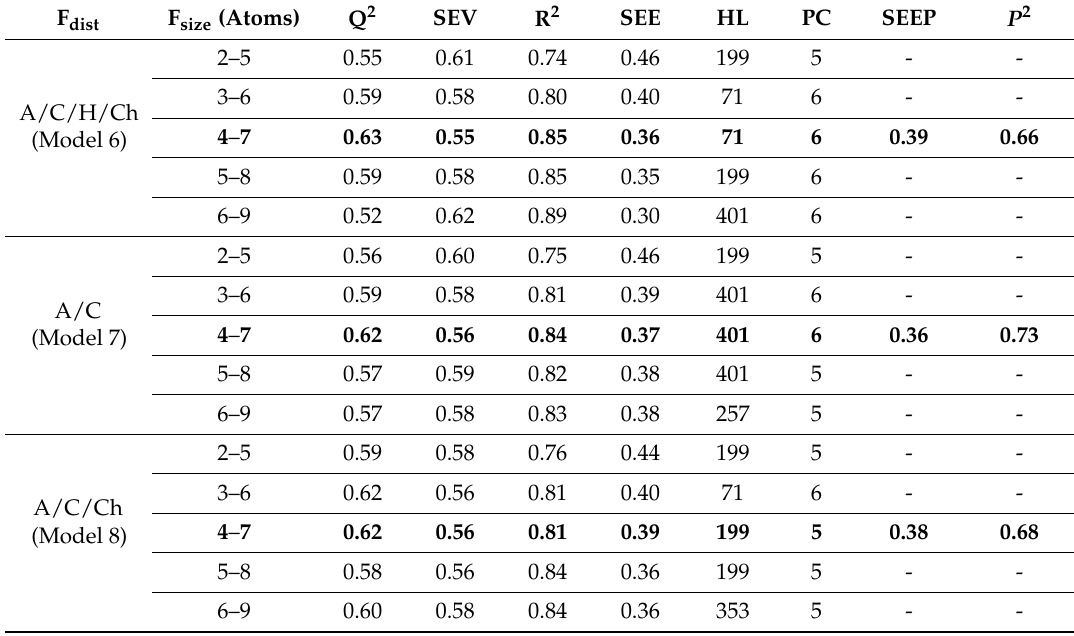
Table 3. Statistical characteristics of HQSAR models with different fragment distinction schemes and fragment size